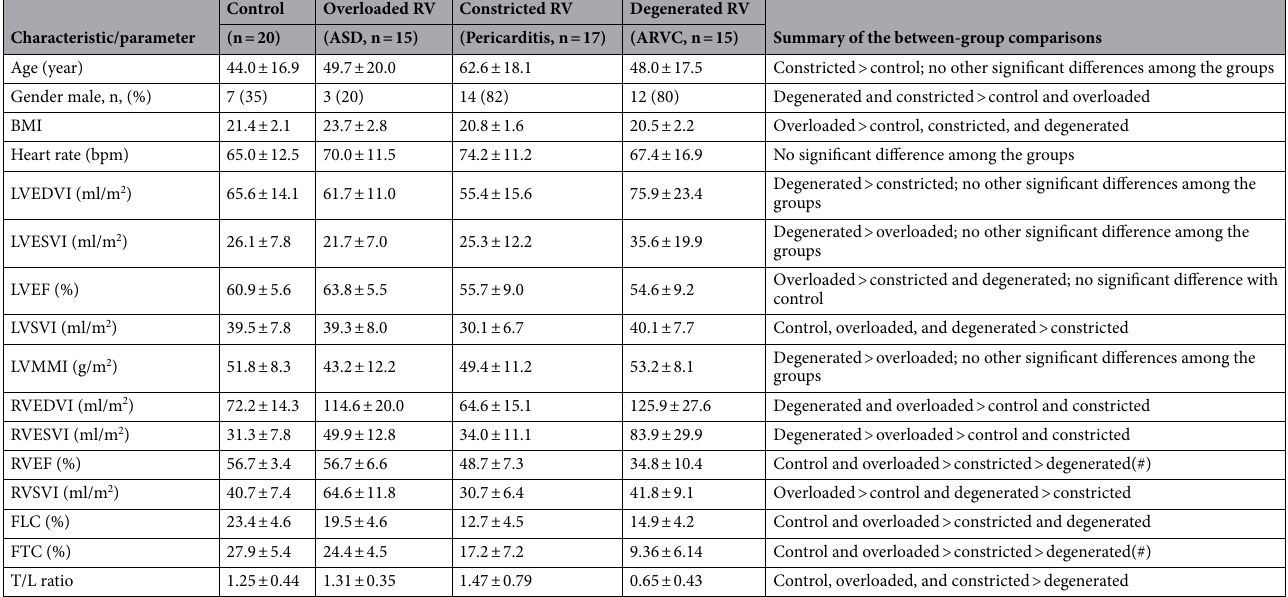
Table 1. Patient characteristics, and volumetric and preliminary parameters of each of the four groups. Continuous variables are expressed as mean ± standard deviation. Nominal variables are expressed as number (%). Differences between two of the four groups were analyzed using Tukey’s test for multiple comparisons. # Of the two preliminary parameters, FTC showed the same tendency as that of RVEF. BMI Body mass index, LVEDVI Left ventricular end-diastolic volume index, LVESVI Left ventricular end-systolic volume index, LVEF Left ventricular ejection fraction, LVSVI Left ventricular stroke volume index, LVMMI Left